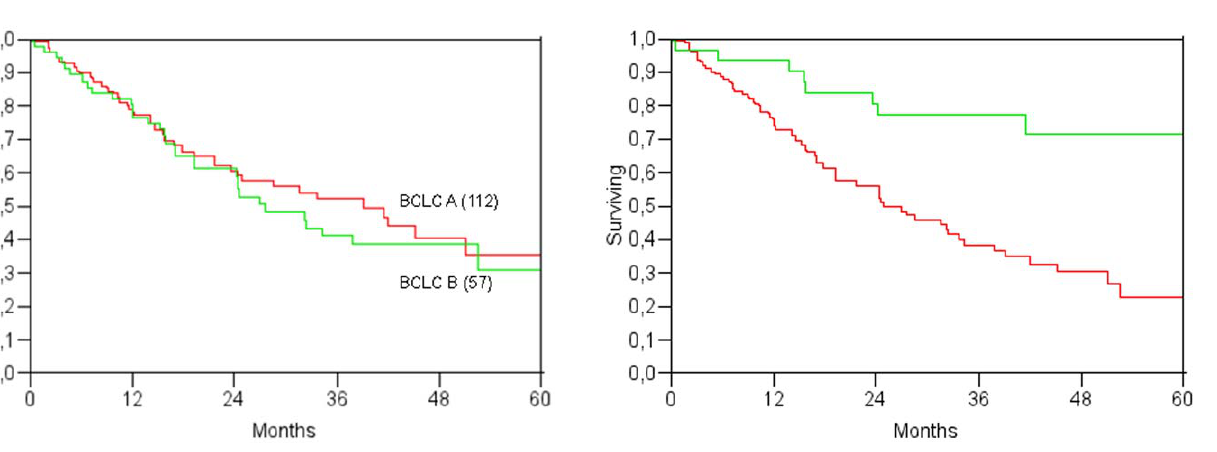
Figure 3. Kaplan-Meier survival curves by BCLC stage (p . 0.05).